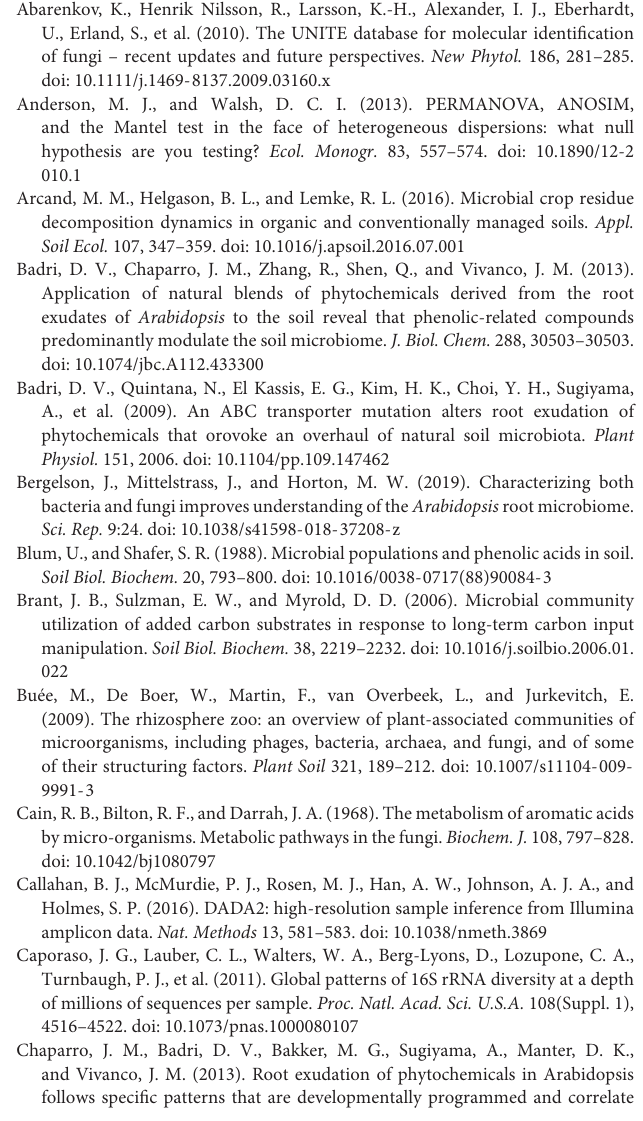
Supplementary Table 1 | Summary of ANOVA results on ergosterol (A) and 16S copy number (B) as a function of the type of phenolic acid, compartment